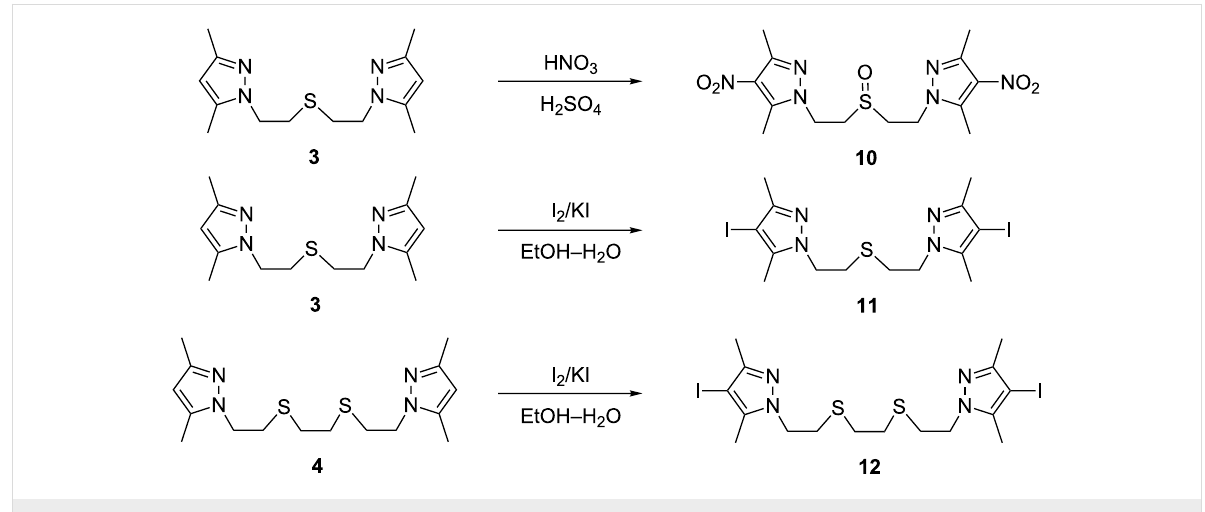
Scheme 4: Preparation of functional